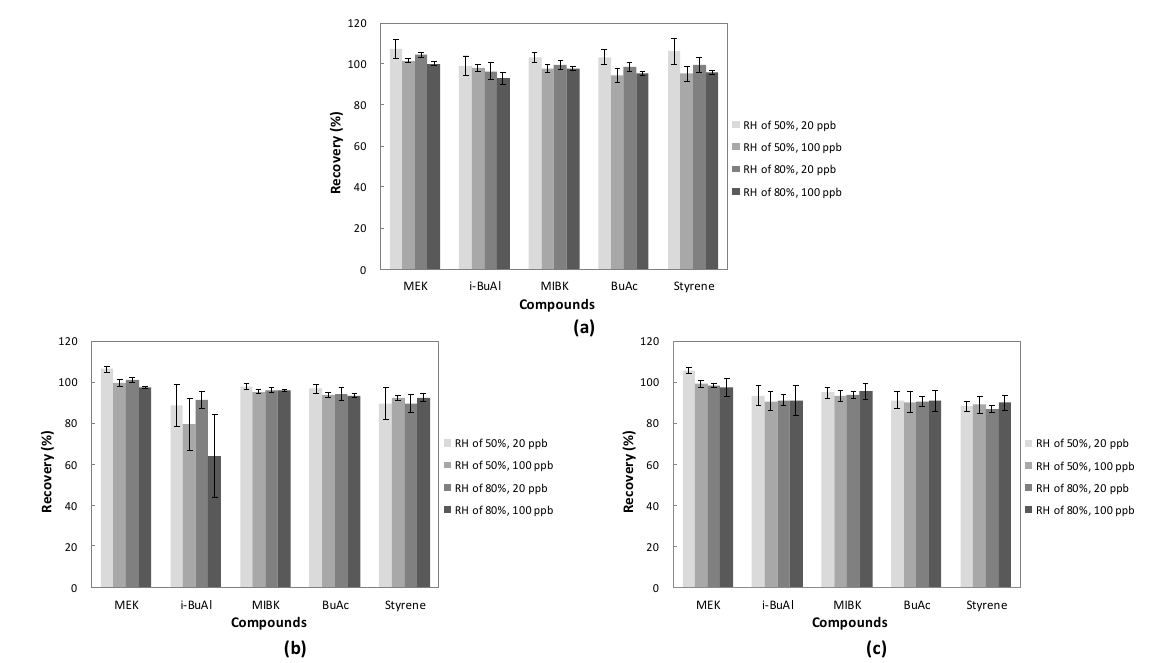
Figure 3. Recovery of each water pretreatment device: ( a ) Desolvator-K; ( b ) Cooler-G; ( c ) Cooler-K.